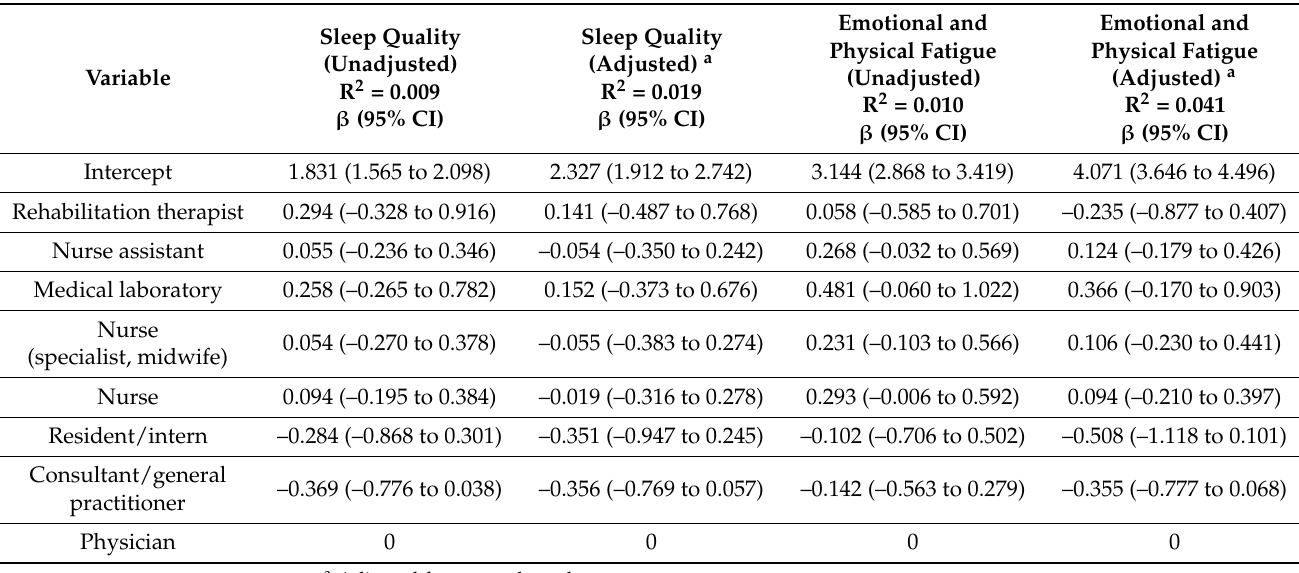
Table 6. Associations between health consequences (sleep quality and emotional and physical